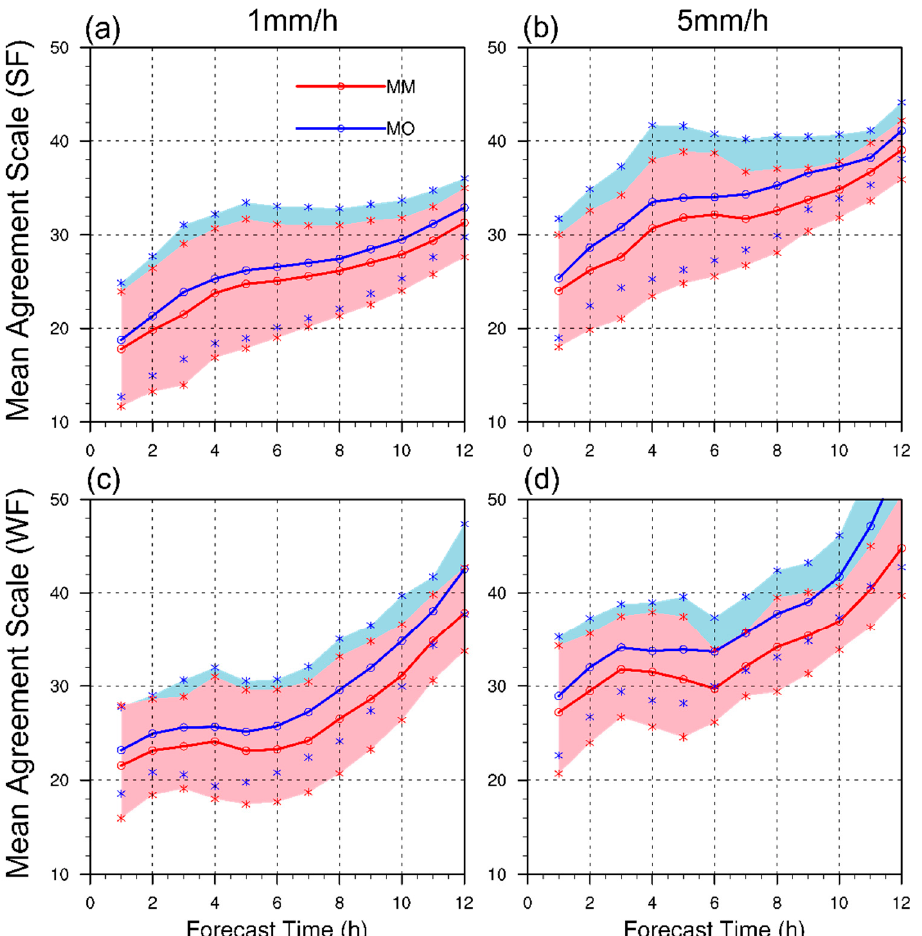
Figure 6. Variations of case- and domain-averaged S mm (red line) and S mo (blue line) for ( a , b ) SF events and ( c , d ) WF events, with precipitation thresholds of ( a , c ) 1 mm/h and ( b , d ) 5 mm/h. The shaded areas represent the standard deviations of different events within certain categories; the red and blue shaded areas represent S mm and S mo , respectively.